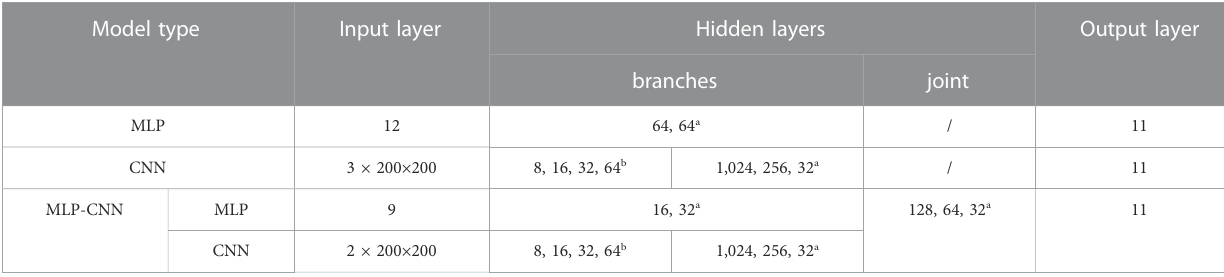
TABLE 5 Architectures of the three trained neural network